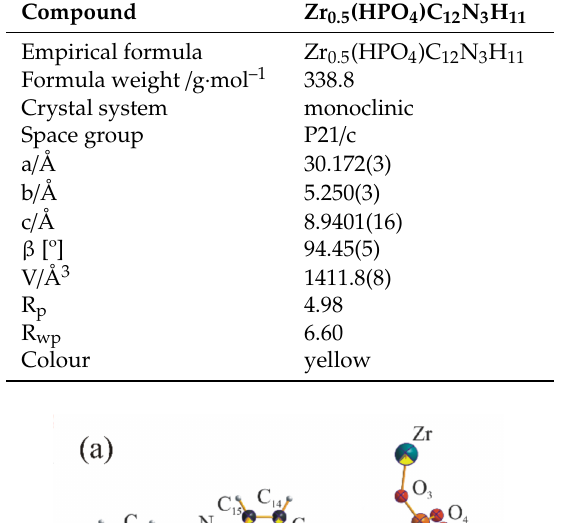
Table 2. Crystallographic data for compound Zr 0.5 (HPO 4 )C 12 N 3 H 11 .